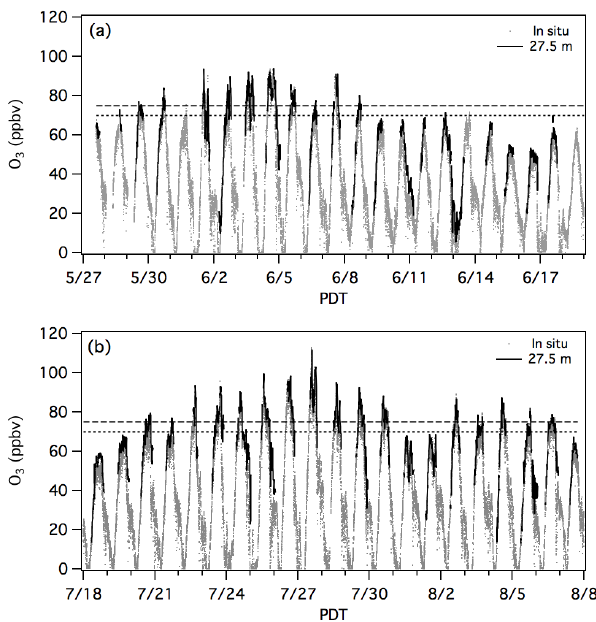
Figure 3. Time series plots (local Pacific daylight time, PDT) of the O 3 concentrations retrieved 815 ± 15m downrange and 27.5m above the surface by TOPAZ (black line) with the measurements from the in situ 2B monitor sampling 5ma.g.l. at the TOPAZ loca- tion (gray dots) during the first (a) and second (b) IOPs. The dashed and dotted lines show the 2008 (75ppbv) and 2015 (70ppbv) O 3 NAAQS, respectively.